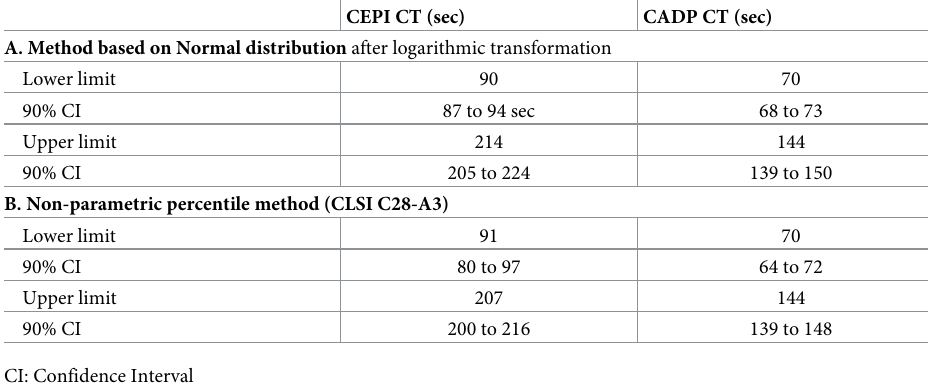
Table 3. Reference intervals of CEPI CT and CADP CT, double-sided.